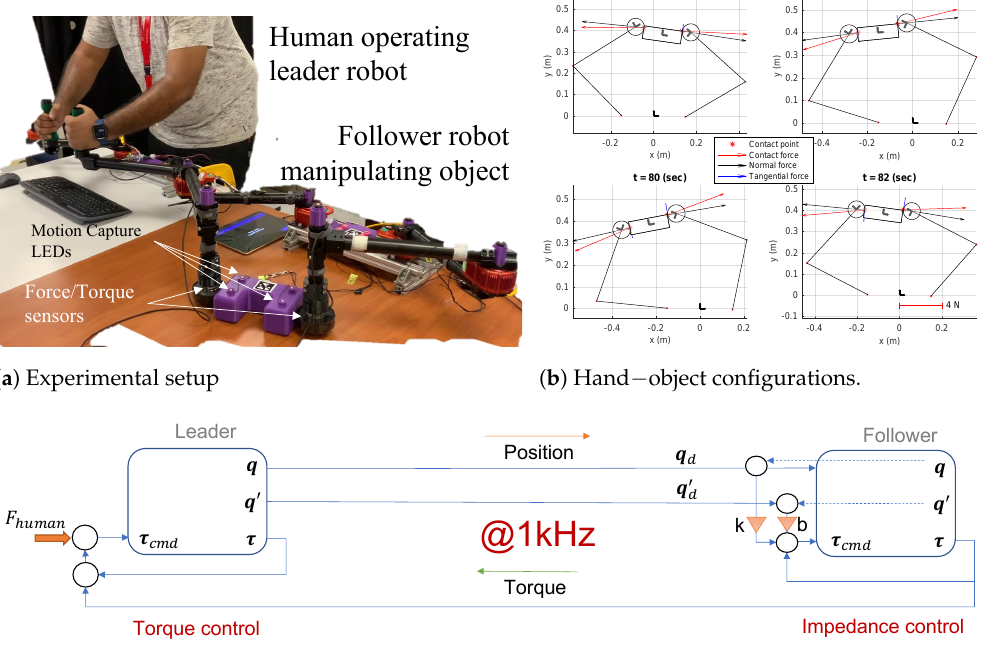
Figure 6. ( a ) Experimental setup with motion-capture LEDs mounted for kinematic tracking and the robot hands equipped with force/torque sensors to sense haptic feedback during manipulation. ( b ) Hand − object configurations and equilibrium forces during the experiment. The decomposition of the equilibrium force into normal and tangential components at the contact point is also shown. ( c ) Impedance − control − based bilateral teleoperation scheme for dual-arm manipulation human haptic